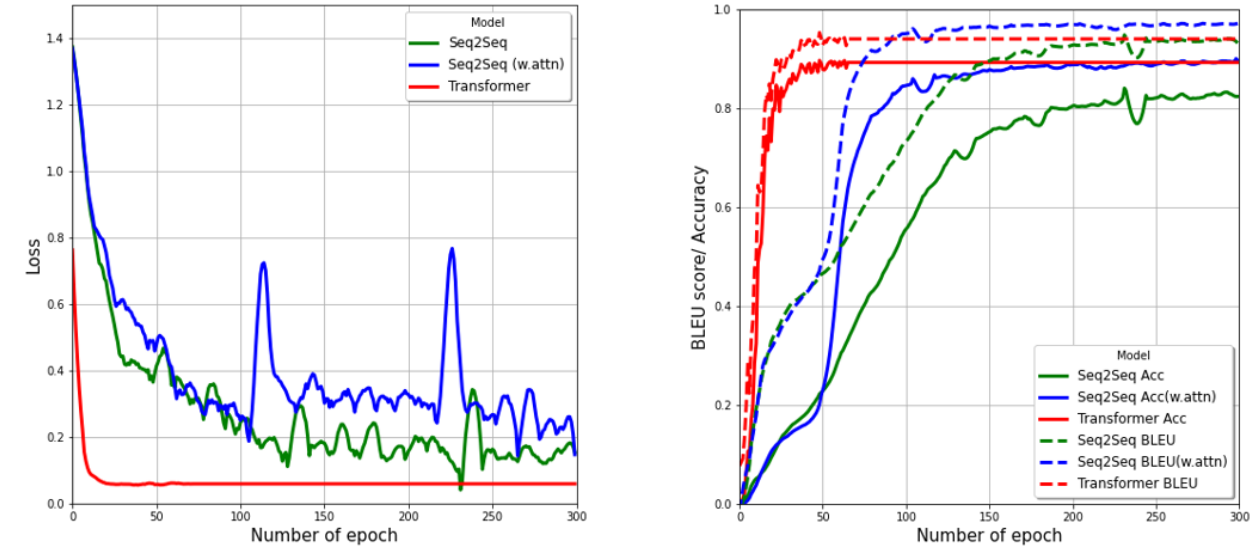
Figure 4. ( Left ) Losses of the models on the validation dataset. ( Right ) Accuracy and BLEU scores obtained from the validation dataset of the model.